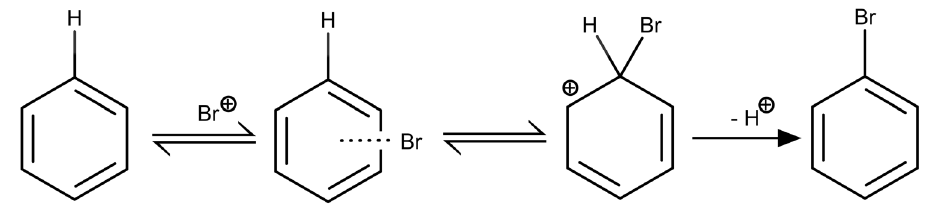
Fig. 5 General mechanism of electrophilic aromatic substitution reaction. Bromination of the benzene molecule as a typical electrophilic aromatic substitution (EAS)